Question: In a single sentence, describe what this figure presents.
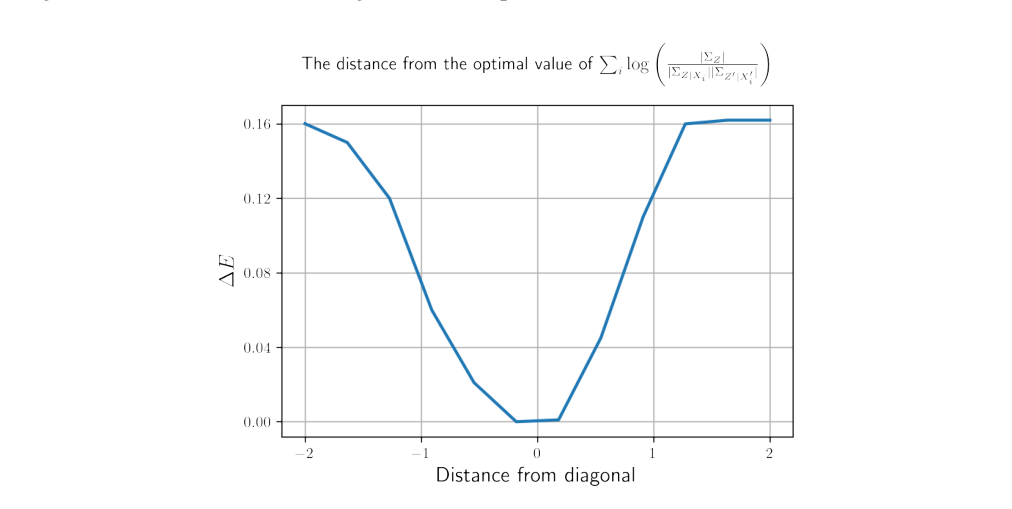
Answer: The optimal solution for the optimization problem is a diagonal matrix. The average distance from a diagonal matrix for different perturbation scales. Experiments were conducted on CIFAR-10 with the ResNet-18 network.